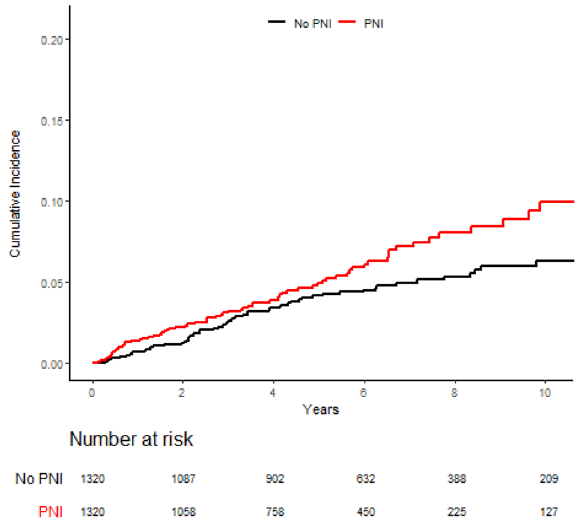
Figure 2. Locoregional recurrence among those with PNI compared to a cohort of PNI-negative propensity- matched